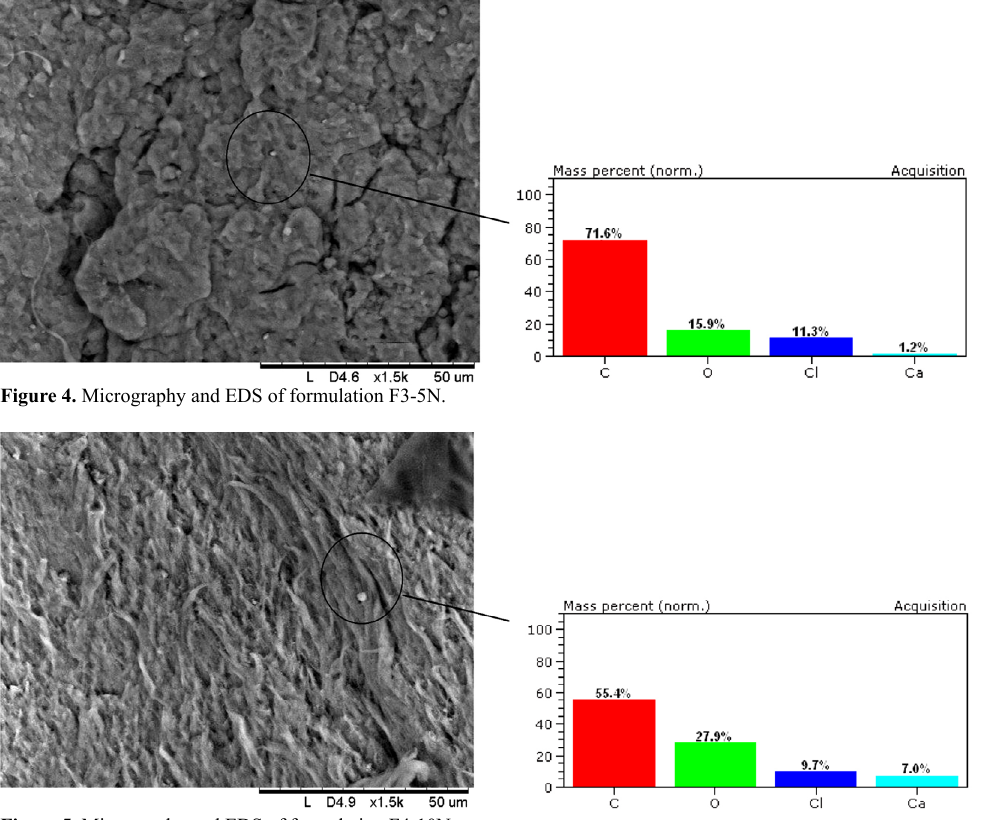
Figure 5. Micrography and EDS of formulation F4-10N.